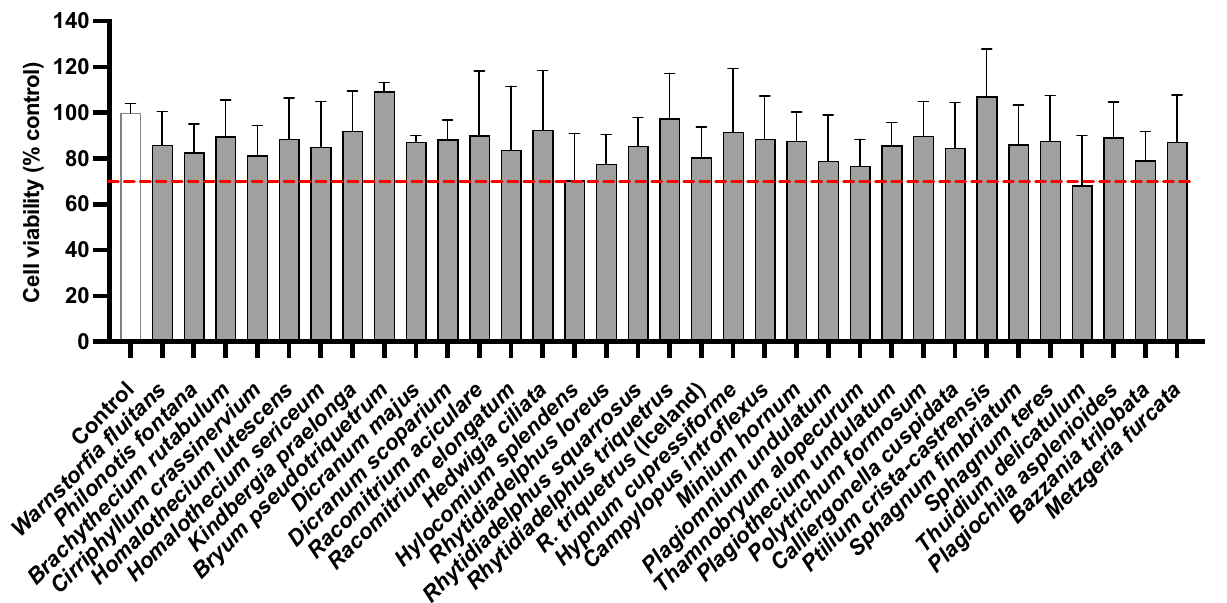
Figure 1. Effect of 70% ethanol extracts on the viability of RAW 264.7 cells determined by MTT assay. Cells were treated with 100 µg/mL of extracts for 24 h. Data represent mean ± standard deviation (n = 3–6) and values are normalized on control (PBS). The tested extracts revealed no significant difference with p -values > 0.05, calculated with ANOVA. The dashed line represents 70% of cell viability. 2.2. Anti-Inflammatory Effects of Extracts in hPrx1 or LPS Stimulated RAW264.7 Murine Macrophage Cells